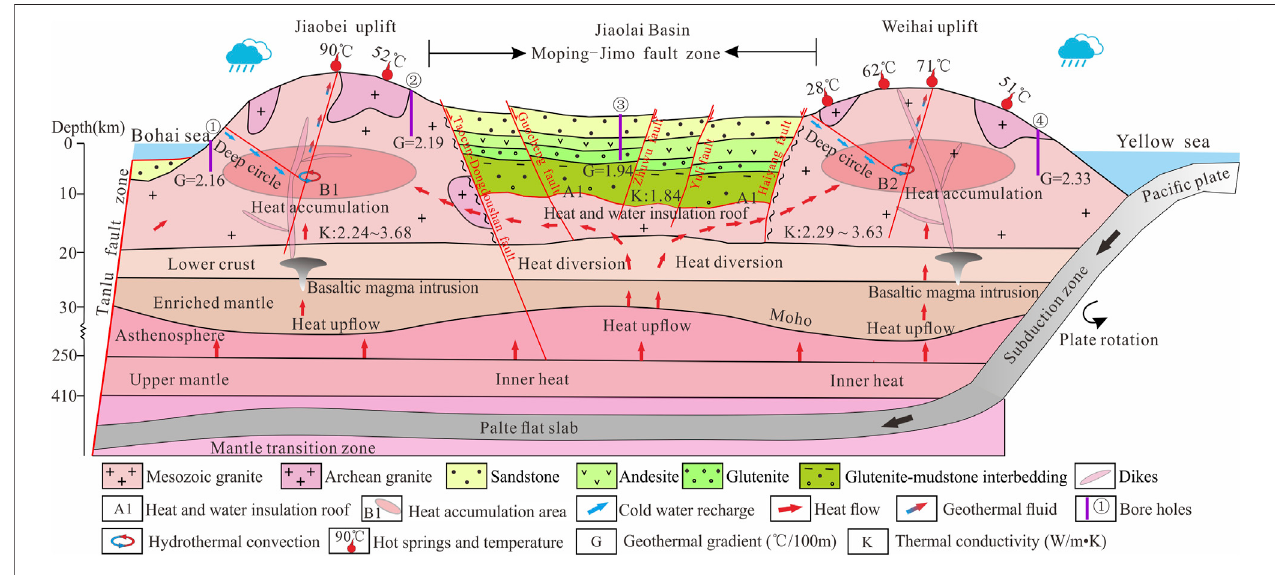
FIGURE 15 | Conceptual model of heat fl ow diversion and